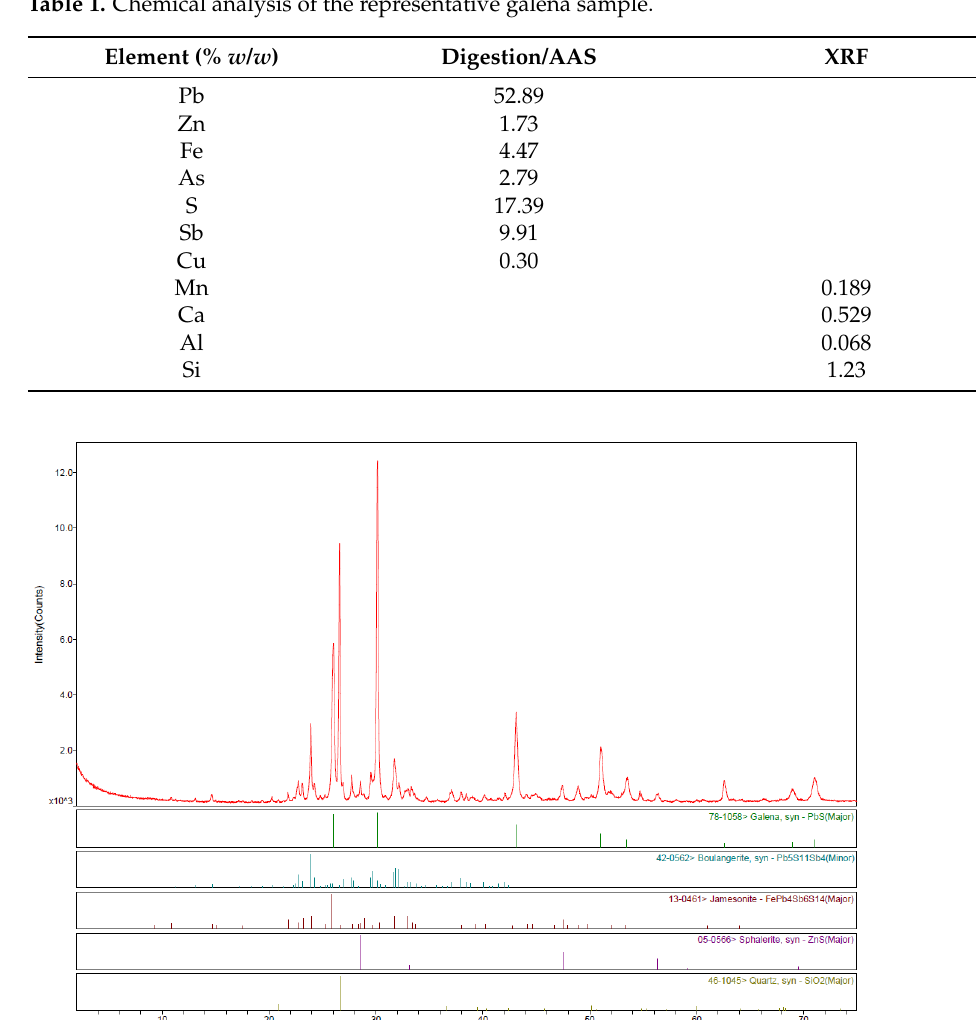
Figure 1. XRD pattern of galena concentrate.